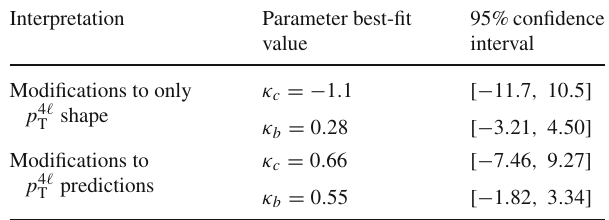
Table 9 Confidence intervals for the Yukawa couplings. Based on the observed 2D exclusion contours, 1D exclusion intervals are only pro- videdforinterpretationswheremodificationtothe p 4 (cid:3) tions are considered. The observed limits are calculated while profiling the other parameter of